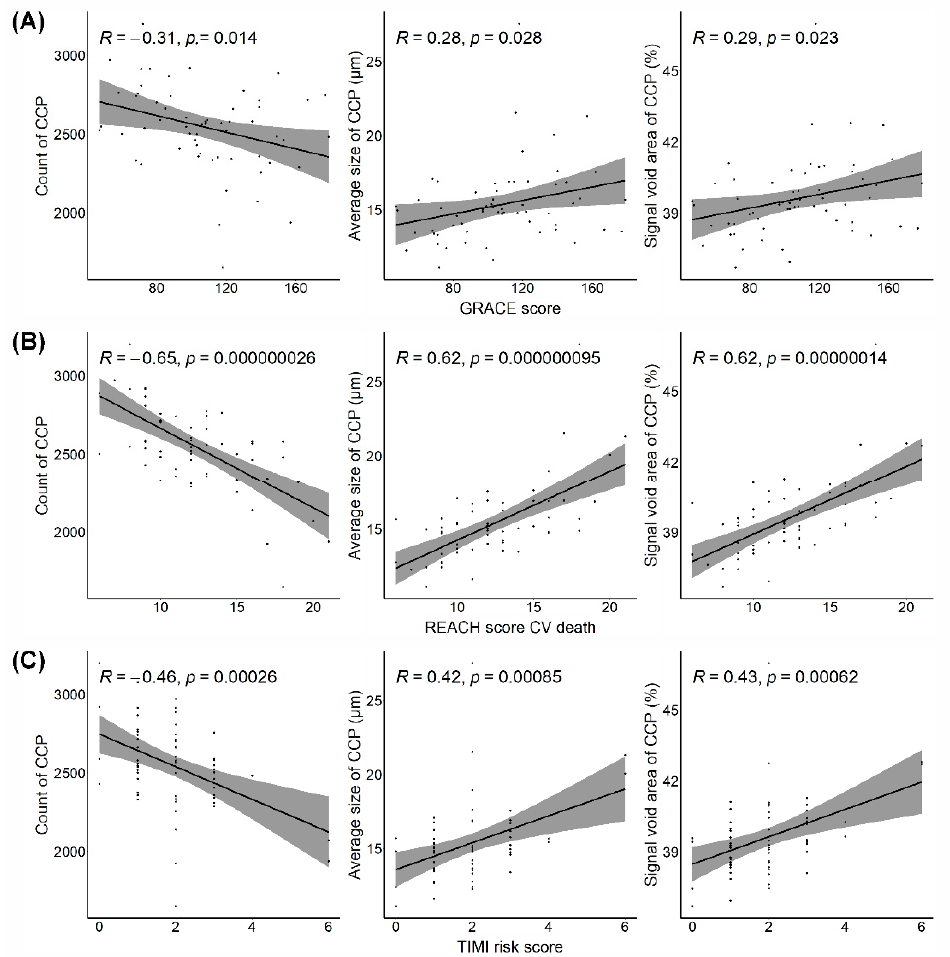
Figure 5. The association between choriocapillaris flow void feature measurement by optical coher- ence tomography angiography and cardiovascular risk scores. ( A ) GRACE score, ( B ) REACH score, ( C ) TIMI risk score. CCP, choriocapillaris; GRACE score, Global Registry of Acute Cardiac Events score; REACH score, Reduction of Atherothrombosis for Continued Health score; CV, cardiovascu- lar.